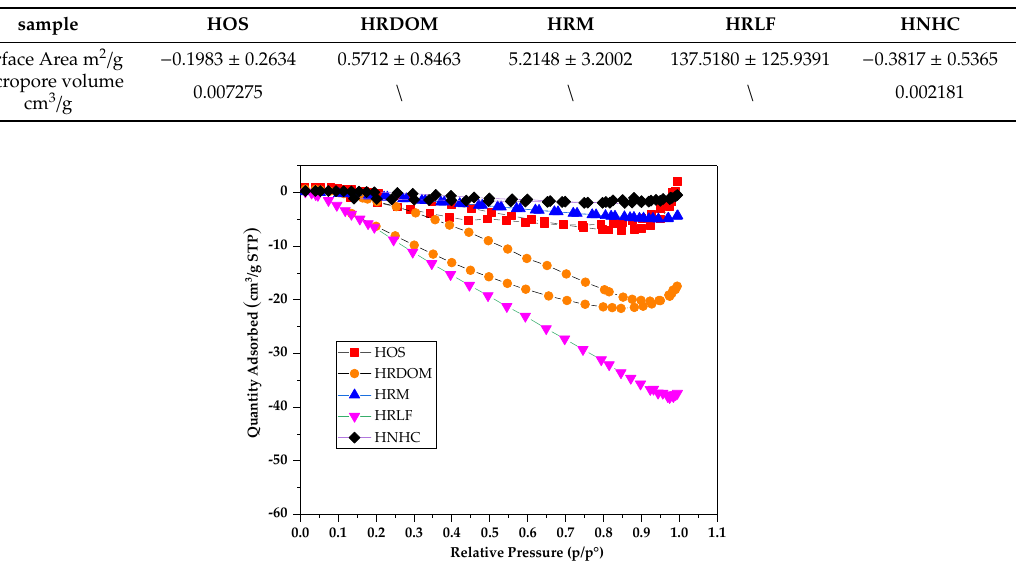
Figure 7. The micro-structure of: ( a ) HOS; ( b ) HRDOM; ( c ) HRM; ( d ) HRLF; ( e ) HNHC. Table 7. Physical properties of di ff erent fractions.